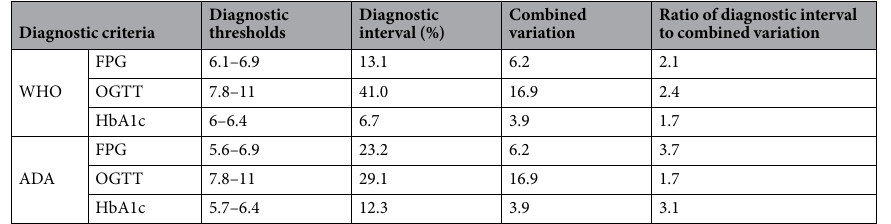
Table 6. Ratio of diagnostic interval to the combined biological and analytical variation for World Health Organisation (WHO) and American Diabetes Association (ADA) diagnostic criteria. FPG = fasting plasma glucose, OGTT = oral glucose tolerance test, HbA1c = glycated haemoglobin A1c. Diagnostic interval is calculated by [(upper threshold − lower threshold)/lower threshold], e.g. for FPG = [(6.9–6.1)/6.1 ×